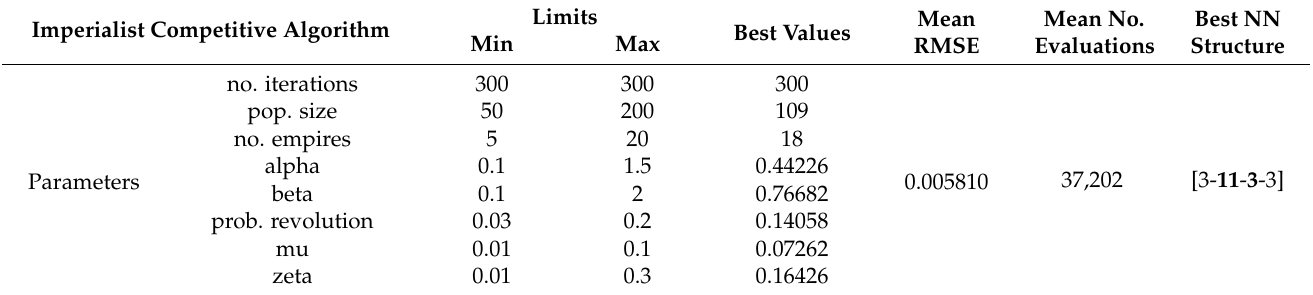
Table A2. The best results provided by the search procedure for the Imperialist Competitive algorithm.